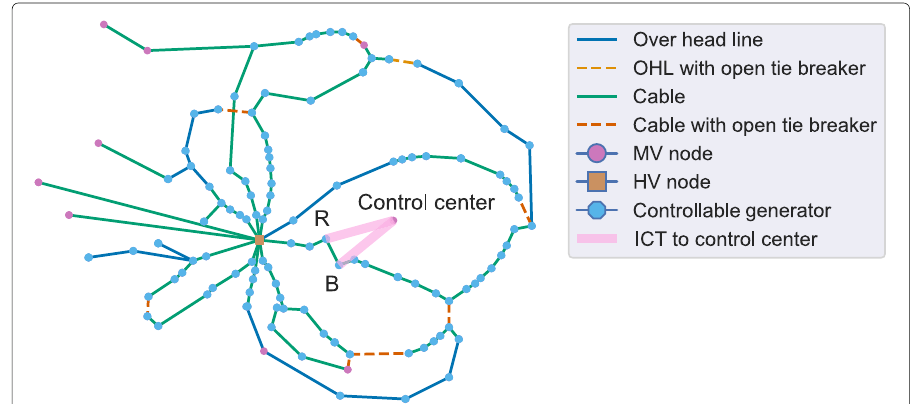
Fig. 1 SimBench semiurban PS with two ICT-connected, remotely controllable generation interconnectors